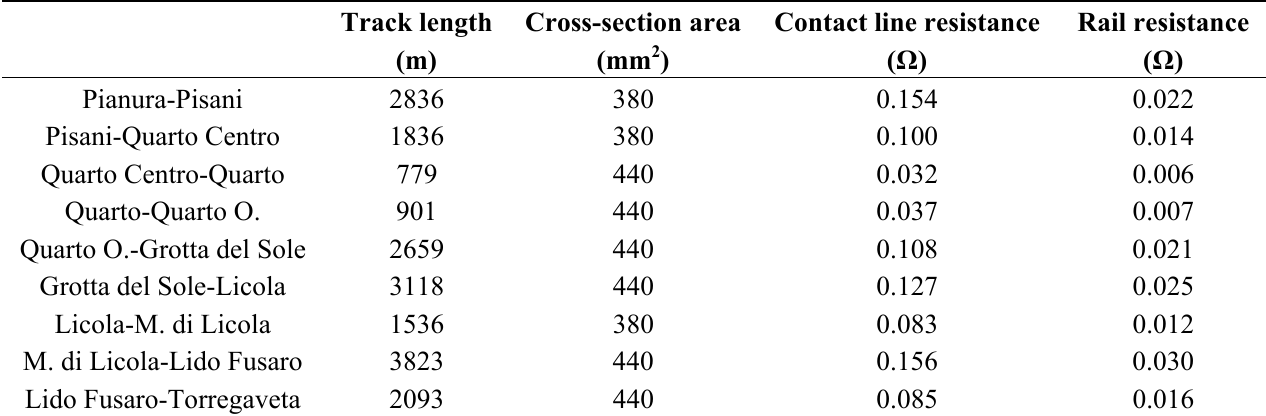
Table 3. Characteristics of the Pianura-Torregaveta branch.